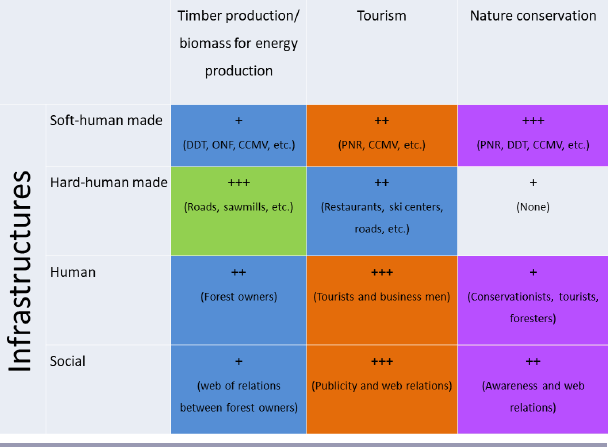
Fig. 6 . Effect of investments in hard-human made infrastructures for forestry functions. Green signifies investment, blue first-tier effect, orange second-tier effect, and purple third-tier effect. The signs +, ++, and +++, refer to the importance of the infrastructure to the relevant forest functions (for more information see Table 1 and Appendix 1). Note: DDT = Direction Départementale des Territoire; ONF = Office Nationale des Forêts; CCMV = Communauté de Communes du Massif du Vercors; PNR = Parc Naturel